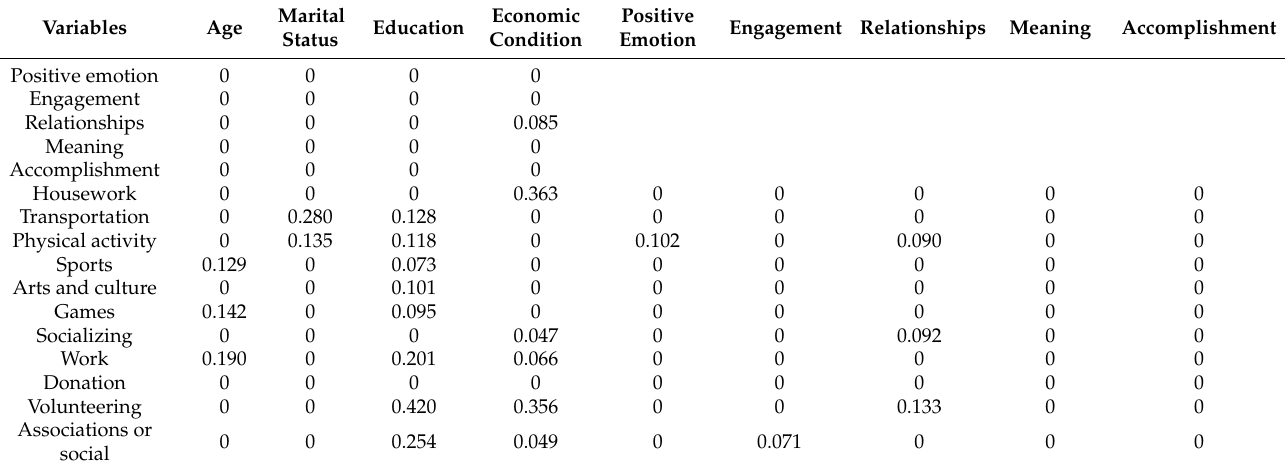
Table 5. The weight of each connection in the network structure